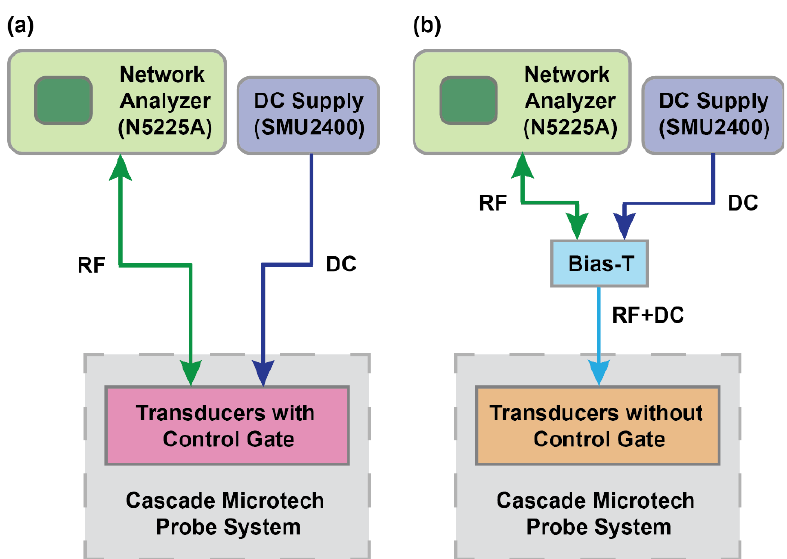
Figure 4. Schematic diagrams of the experimental measurement setup for switchable transducers ( a ) with a control gate and ( b ) without a control gate. In the case of transducers with a control gate, the RF signal was driven and sensed from IDTs and DC bias was applied to the control gates. On the other hand, combined RF and DC bias were applied to the IDTs using external bias-T for the transducers without a control gate.